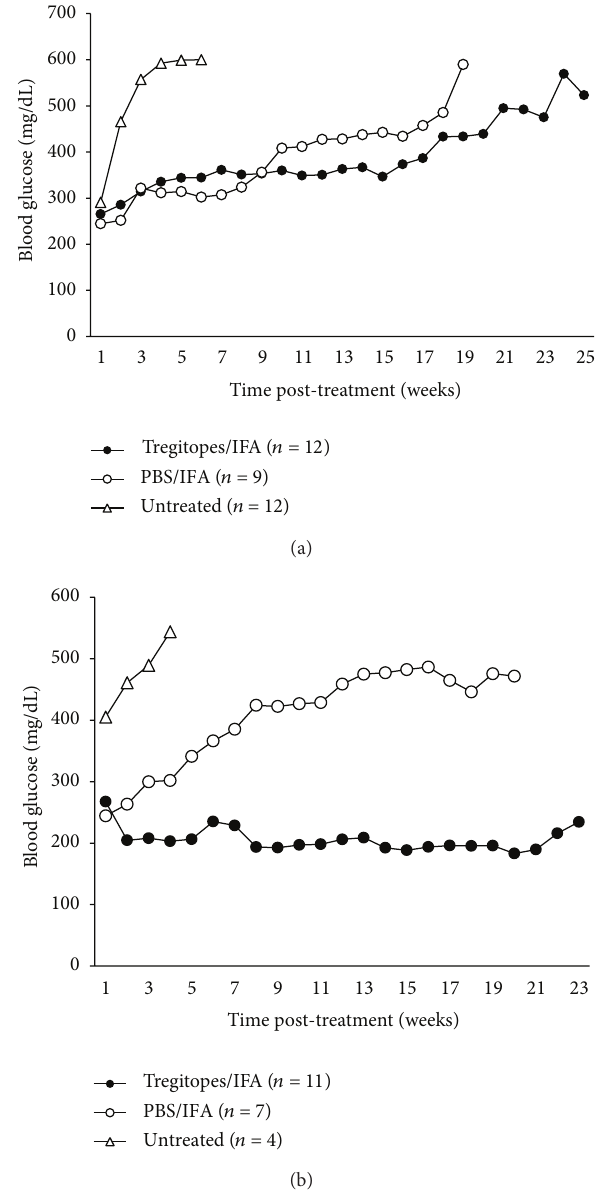
Figure 6: Treatment with Tregitopes in IFA at onset of diabetes. Female NOD mice were monitored for blood glucose (BG) levels. Disease onset was defined as BG between 200 and 250 mg/dL measured on two consecutive days, at which time mice were entered into the study. Mice received a single subcutaneous injection in the flank of either mTregitopes 167 and 289 (total 20 𝜇 g) formulated in IFA or PBS in IFA (as a vehicle control) or they were left untreated. BG levels were then measured weekly. In the initial study (a), Tregitopes suppressed the progression of diabetes in seven of twelve mice,whereasIFAalonehadlessofaneffect.Thisstudywasrepeated (b), showing successful “cure” of diabetes after onset. All pair-wise comparisons are significant ( 𝑃 ≤ 0.05